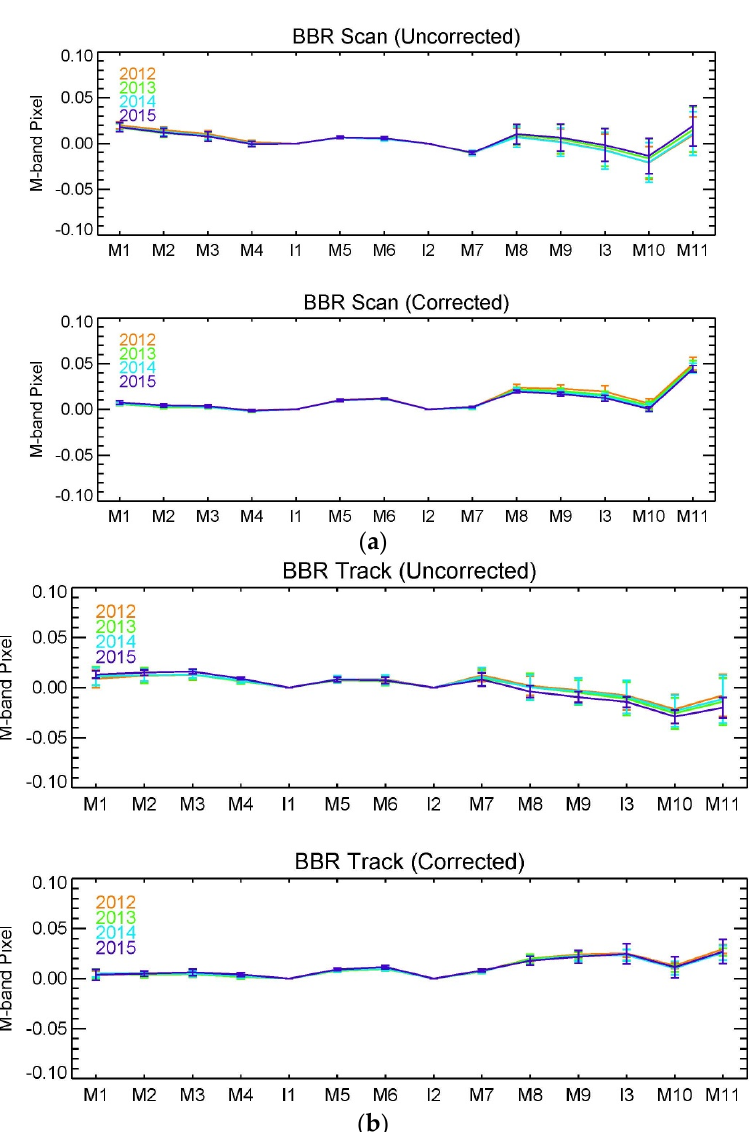
Figure 8. The yearly-averaged BBR results after image rotation correction in both along-scan ( a ) and along-track ( b ) directions before and after image rotation correction, referenced to Band I1.